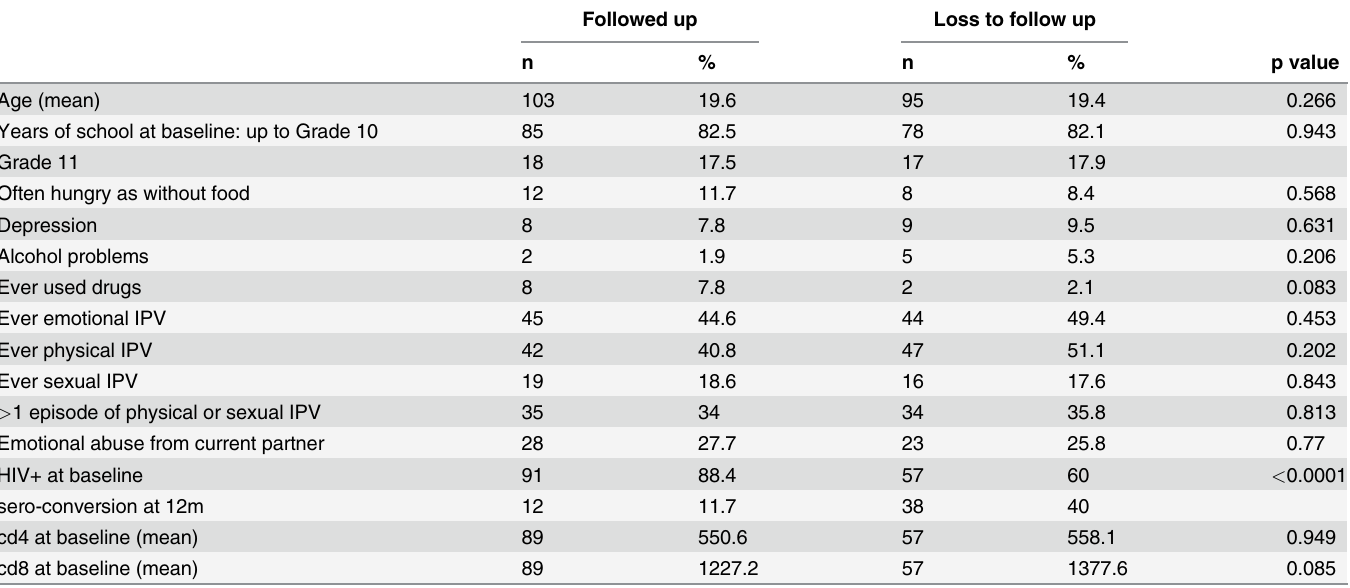
Table 1. Comparison of baseline characteristics of women who were HIV + at baseline, sero-convert at 12 months, and were retained in the analy- sis, and those lost to follow up.